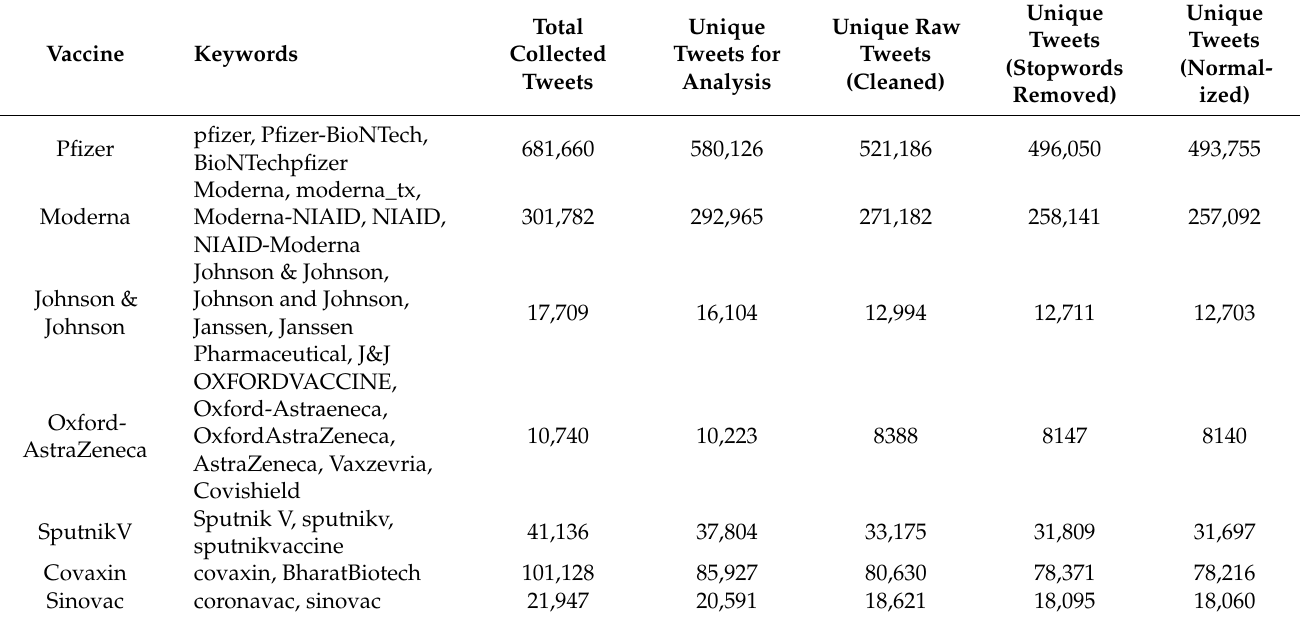
Table 2. Twitter Dataset 1: Vaccination tweets used in our experimental